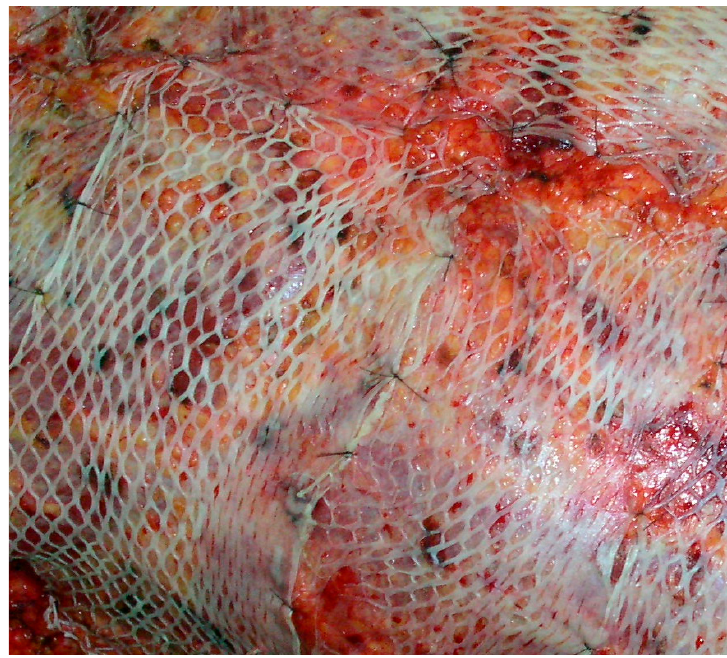
Figure 2. Intermediate-thickness skin grafts on a burn wound.